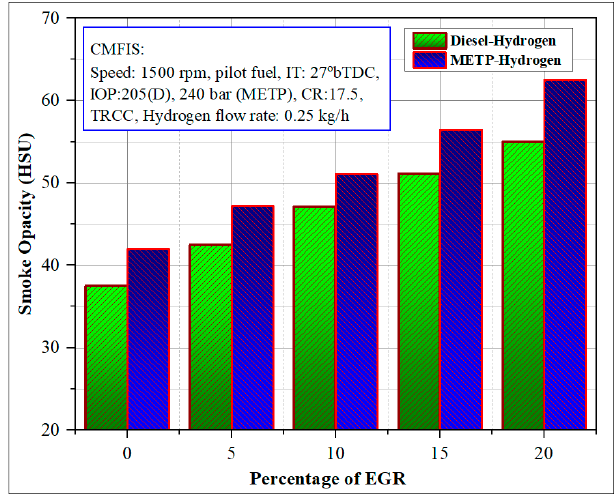
12 of 27 Figure 5. Effect of Exhaust Gas Recirculation (EGR) on the Brake Thermal Efficiency (BTE) with induction method. For the same EGR rates, decreased BTE was obtained for METP-Hydrogen compared to diesel– hydrogen. For the similar injected fuel during dual fuel process hydrogen injection, improved performance has been observed. This may be due to the higher flame velocity of H 2 . In this hydrogen injection method using EGR, decreased BTE has been noticed that is caused by the effect of inactive radicals present in tire out exhaust gas. Further, it decreases the combustion process by the increased temperature of charge in the combustion chamber, leading to reduced volumetric efficiency. The EGR effect on the smoke opacity for diesel/METP-Hydrogen injection is presented in Figure 6. Increased smoke opacity has been noticed with the addition of EGR in the injection of hydrogen. The utilization of EGR in a dual fuel engine does not outcome any improvements in smoke emission. The presence of exhaust gas significantly decreases air proportionately, leading to a reduction in the oxidation rates. However, hydrogen use in the combustion along with EGR marginally decreases smoke emission. This may be attributed to increased ignition centers caused by the higher flame velocity of hydrogen. A lower percentage of exhaust gas (5% and 10%) changes the smoke emission marginally